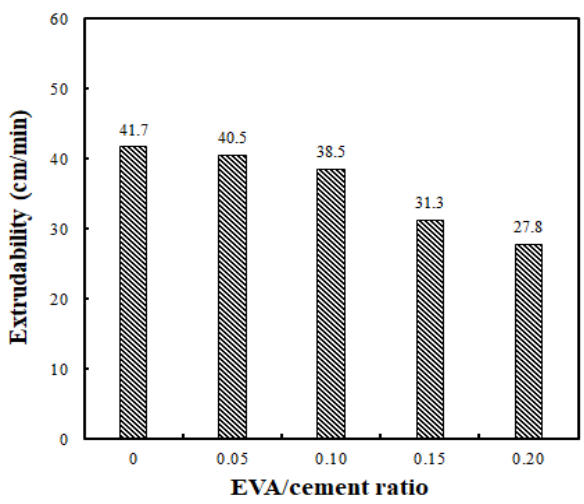
Figure 7. Comparison of extrudability using di ff erent EVA / cement